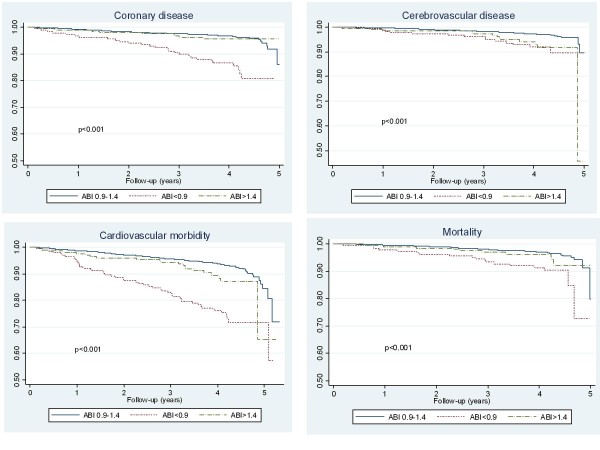
Kaplan-Meier survival curves for coronary and cerebrovascular diseases, cardiovascular morbidity and mortality among patients with different ankle-brachial index (ABI).